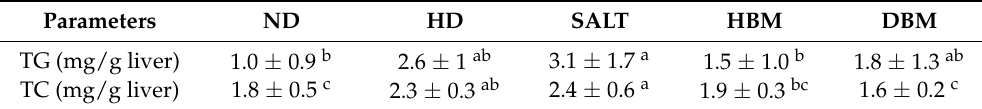
Table 3. Hepatic lipid